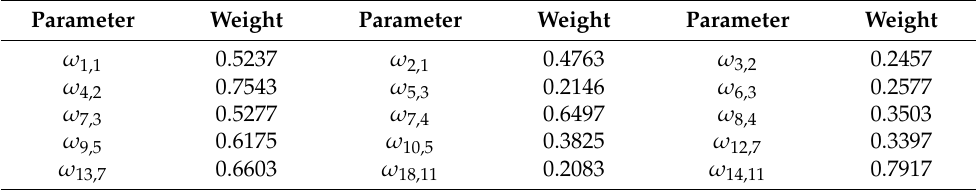
Table 4. The optimized weight table by